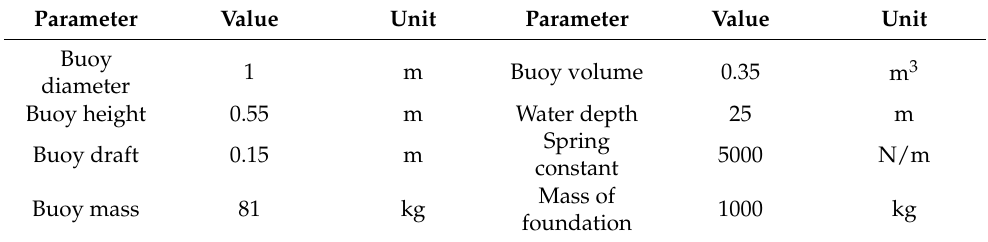
Figure 1. Left picture shows the experimental setup just before deployment. The right figure shows a sketch of the setup. The small buoy at the bottom is used to lift the shackle connecting the line and foundation in order to avoid wear on the line. Table 1. Details of the experimental set